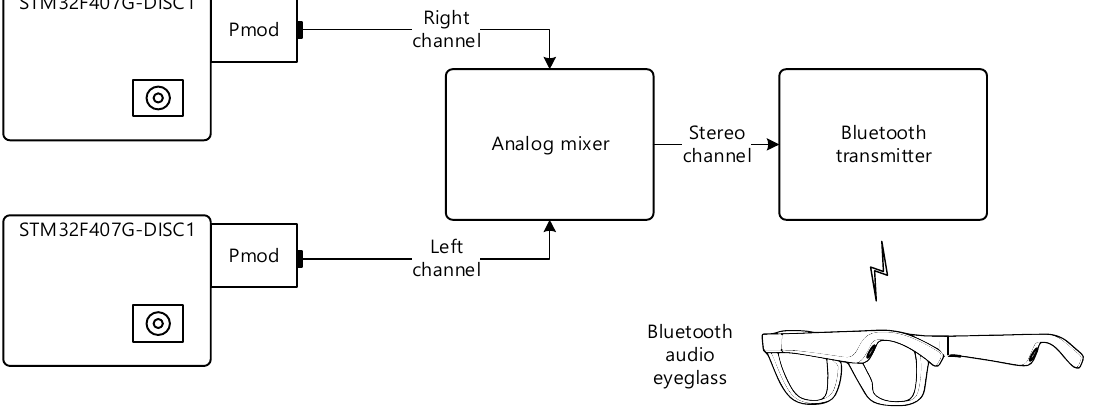
Figure 10. Eyeglass receiver device realization.